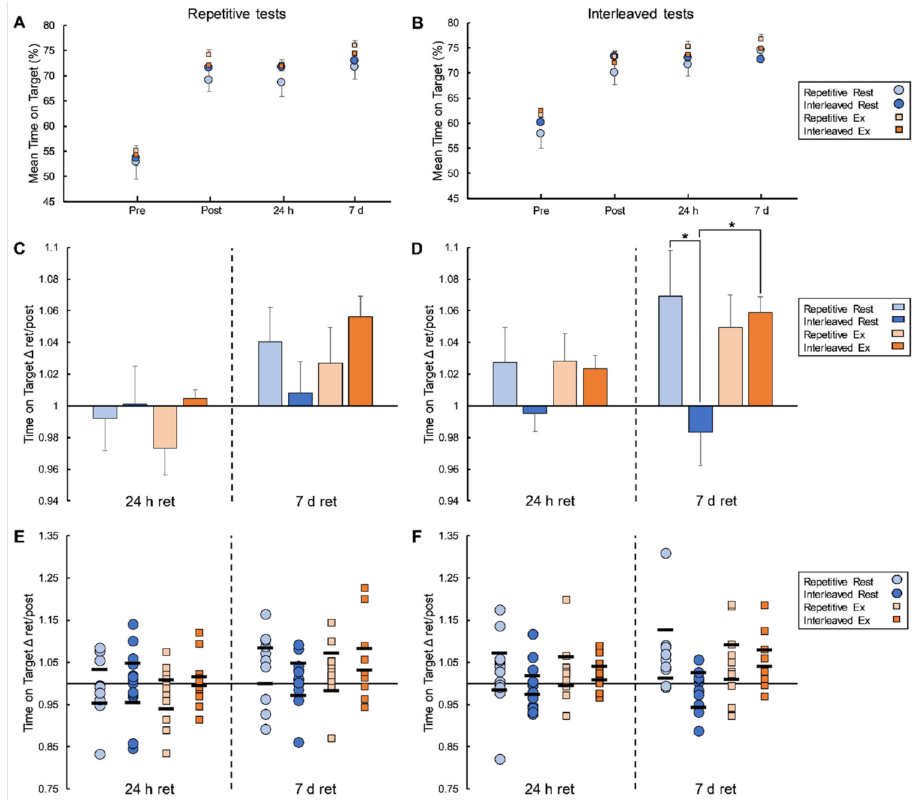
Figure 3. Visuomotor tracking task (VTT) results. Panels ( A , B ) depict raw time on target (ToT%) data for repetitive ( A ) and interleaved ( B ) tests when averaged across participants in each group for each time point. Panels ( C , D ) show average change in ToT% for repetitive ( C ) and interleaved tests ( D ) over the consolidation periods for each group, with performance at each retention test expressed as a ratio relative to post-practice test performance. Error bars in panels ( A – D ) reflect standard error. Asterisks (*) in panels ( C , D ) denote statistically significant differences between groups. Panels ( E , F ) show individual data points contributing to the group averages in ( C , D ). Horizontal lines in panels ( E , F ) represent 95% confidence